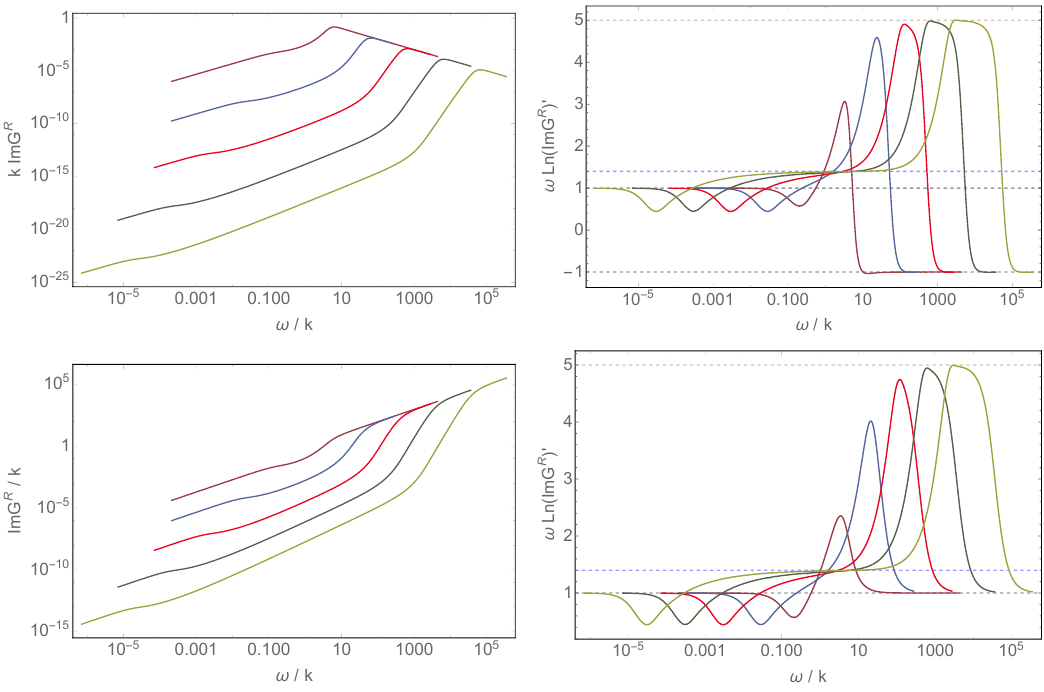
Figure 6 . Plots displaying the behaviour of the spectral function Im G R ( ! ) for a scalar (cid:12)eld with (cid:1) = 1 (top plots) and (cid:1) = 2 (bottom plots) for various values of (cid:0) =k = 0 : 7 (cid:2) 10 n : purple ( n = 1), blue ( n = 2), red ( n = 3), dark green ( n = 4), light green ( n = 5). In the left plot we see the build up of intermediate scaling regions as (cid:0) =k increases with scaling behaviour governed by the spectral functions Im G R ( ! ) (cid:24) ! 7 = 5 and Im G R ( ! ) (cid:24) ! 5 of the two hyperscaling violation geometries. I II The right plot shows the more stringent test of scaling behaviour by plotting the derivative of the